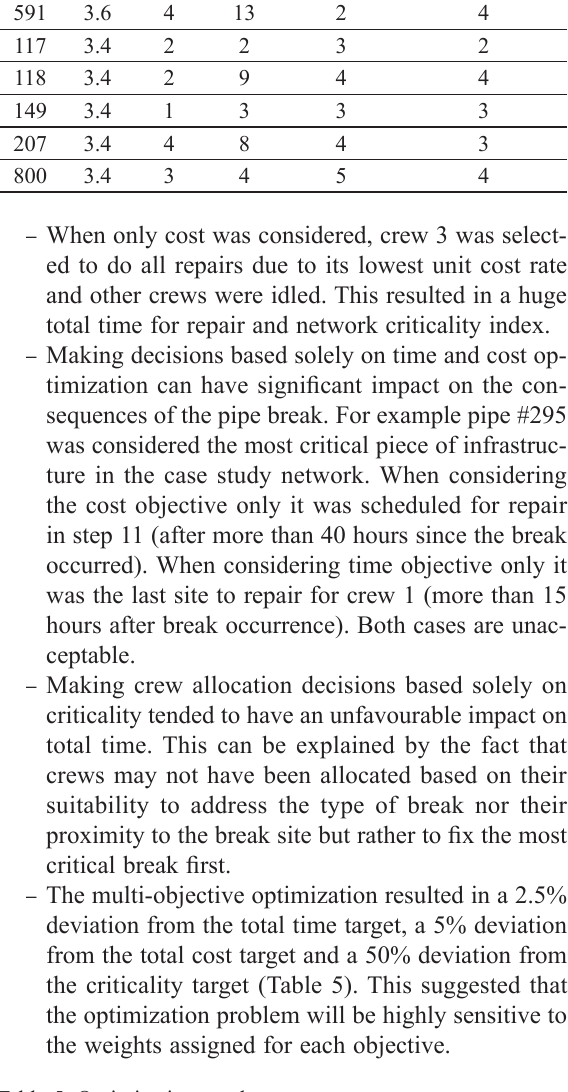
Table 5. Optimization results